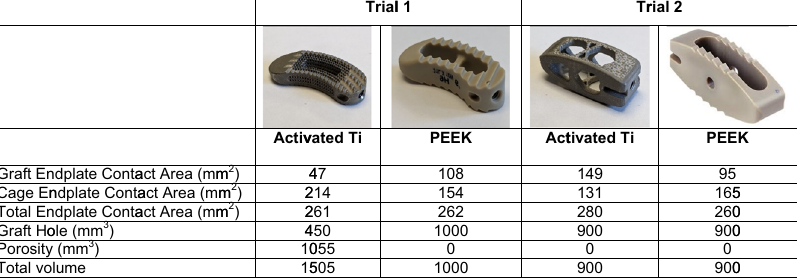
endplate contact areas (ECAs) are noted. Similarly for Trial 2, con- sidering 26 – 28 mm length × 10 mm width Ti and PEEK implants, comparable graft and cage ECAs are also